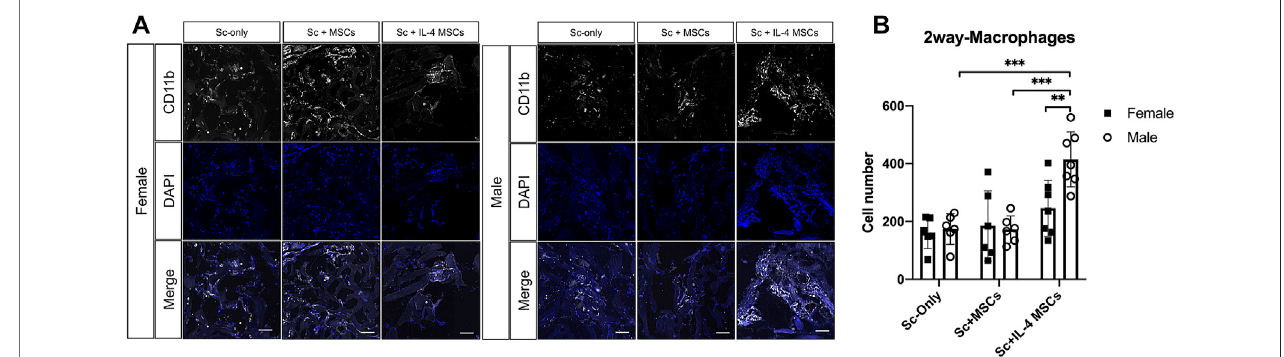
FIGURE 6 | Immunohistochemistry staining and analysis of CD11b/DAPI inside the scaffolds of critical size bone defect healing after 6 weeks in female and male mice. (A) Representative images of CD11b/DAPI stained macrophages in all groups. (Blue: DAPI/nucleus; White: CD11b/Macrophage marker. Bar (cid:2) 100 µm). (B) Number of cells counted from the immunohistochemistry images. Female Sc-only, n (cid:2) 6; female Sc + MSCs, n (cid:2) 6; female Sc + IL-4 MSCs, n (cid:2) 7; male Sc-only, n (cid:2) 6; male Sc + MSCs, n (cid:2) 6; male Sc + IL-4 MSCs, n (cid:2) 7. **: 0.001 ≤ p < 0.01, ***: 0.0001 ≤ p < 0.001, ****: p < 0.0001.